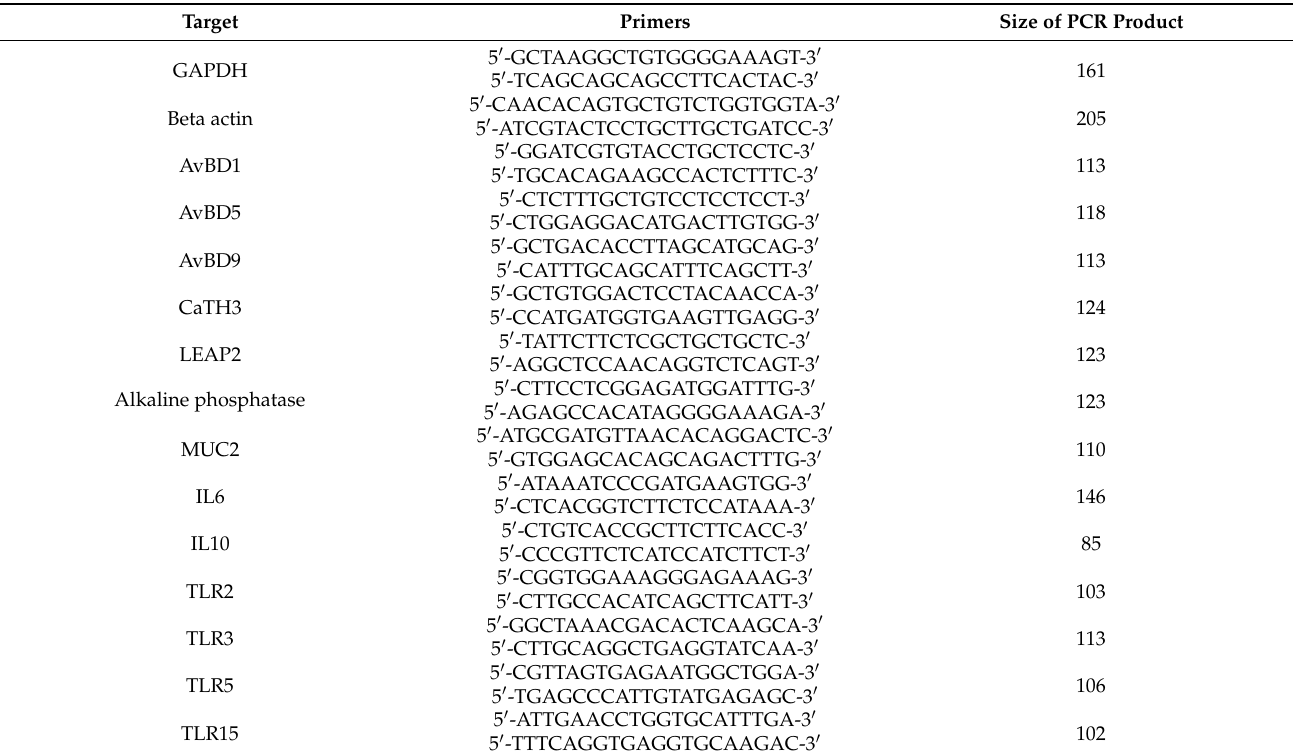
Table 2. Primers for analyzing the relative mRNA abundance of antimicrobial peptides, alkaline phosphatase, mucin gene, inflammatory cytokines, and toll-like receptors 1 . Target Primers Size of PCR